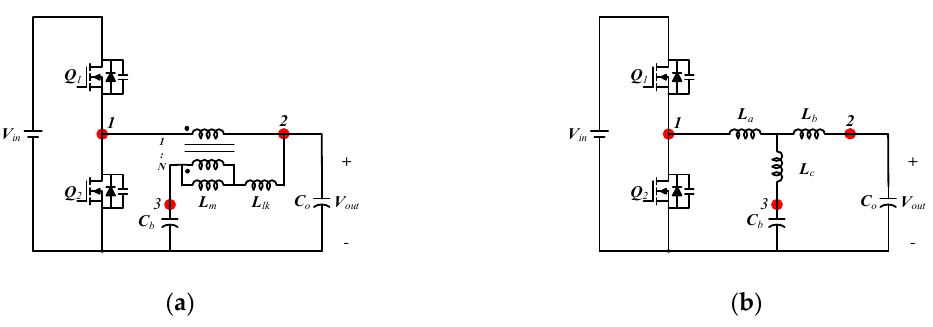
Figure 3. Ripple current cancellation circuit: ( a ) transformer type; ( b ) T-type equivalent form.